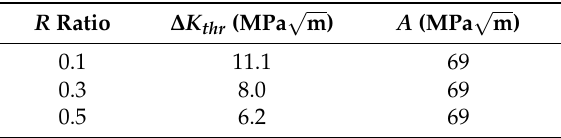
Figure 8. ( a ) Comparison of measured and computed curves for AM 316L; ( b ) Exponent error of the fitted curves as computed using Equation (5). Index “1” indicates crack growth parallel to the build direction, while index “2” indicates crack growth perpendicular to the build direction. Table 5. Values of ∆ K thr and A used in Figure